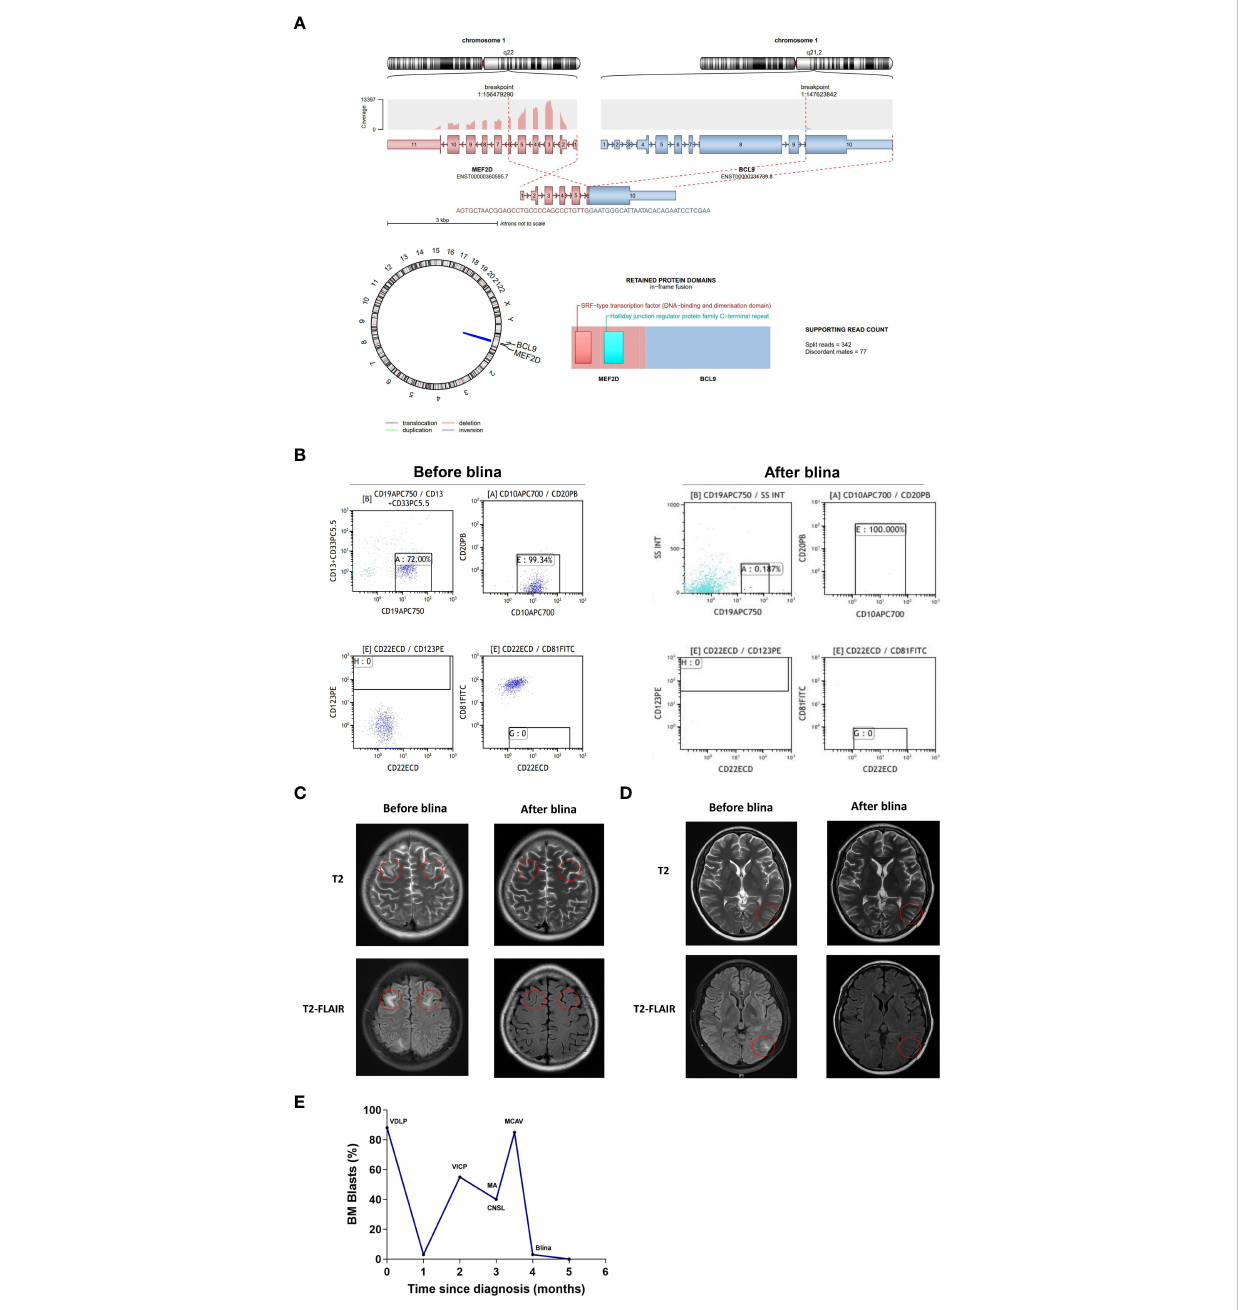
FIGURE 2 Clinical data of case 2. (A) Schematic diagram of the MEF2D::BCL9 fusion before and after blina. (B) Flow cytometry analysis of CSF before and after blina. (C, D) Brain MRI analysis before and after blina. (E) Timeline of treatments and responses of case 2. VDLP, vincristine, daunorubicin, L-asparaginase and prednisone; VICP, cyclophosphamide (750 mg/m 2 ), idarubicin 10 mg per week for 4 times, vincristine 1.5 mg/m 2 per week for 4 times, prednisone 60 mg/m 2 , once daily, 4 weeks; MA, methotrexate 1 g/m 2 , intravenously, d1, Ara-c 3 g/m 2 , intravenously, q12h d2-3; MCAV, Mitoxantrone liposomes 40 mg combined with CAV regimen (cladribine 5 mg/m 2 , d2-6, cytarabine 20 mg q12h, d2-8 and dose-escalation of venetoclax d1-7); Blina, Blinatumomab (9 µg d1-7, 28 µg d8-28); CNSL, central nervous system